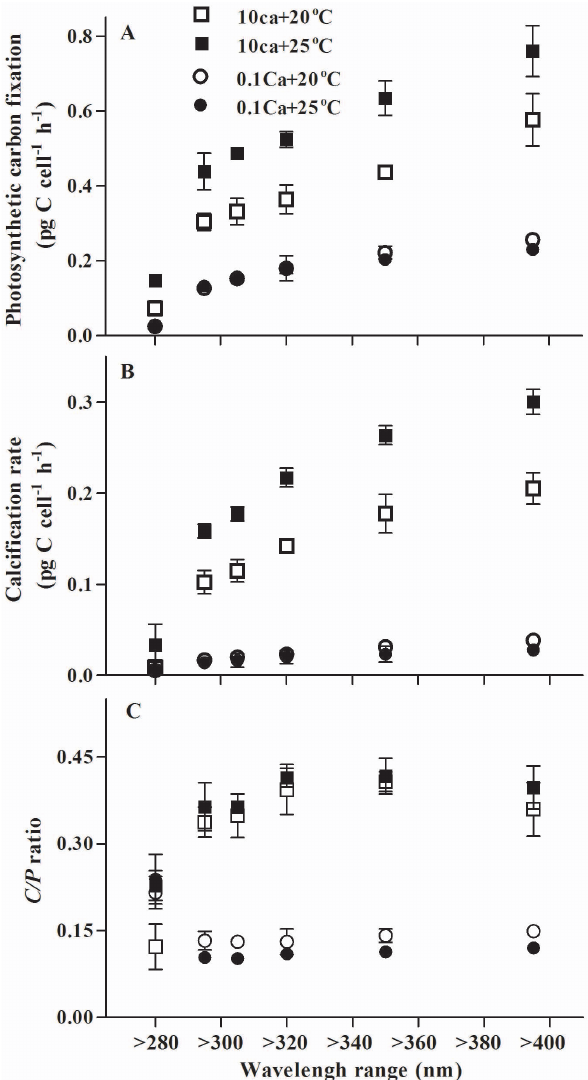
Fig. 5. (A) Photosynthetic carbon fixation (in pgCcell − 1 h − 1 ) , (B) Calcification rate (in pgCcell − 1 h − 1 ) and, (C) C / P ratio of Emiliania huxleyi cells grown at HCa (squares) and LCa (circles) and exposed to different radiation and temperature treatments for 2h. Open and filled symbols are cells exposed at 20 ◦ C and 25 ◦ C, respectively. The bars on top of the symbols represent the standard deviation ( n = 3).